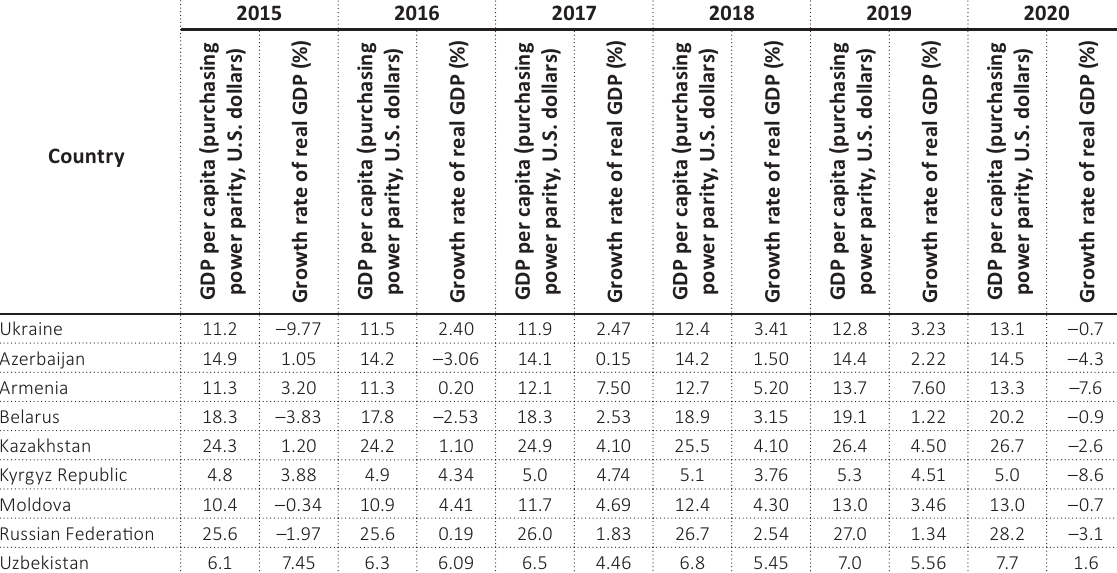
Source: Based on the data from World Bank